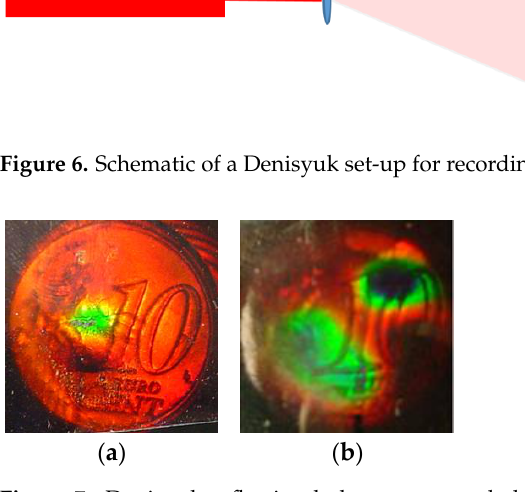
Figure 6. Schematic of a Denisyuk set-up for recording reflection holograms. The pressure applied to the holograms was measured using an INSTRON machine.